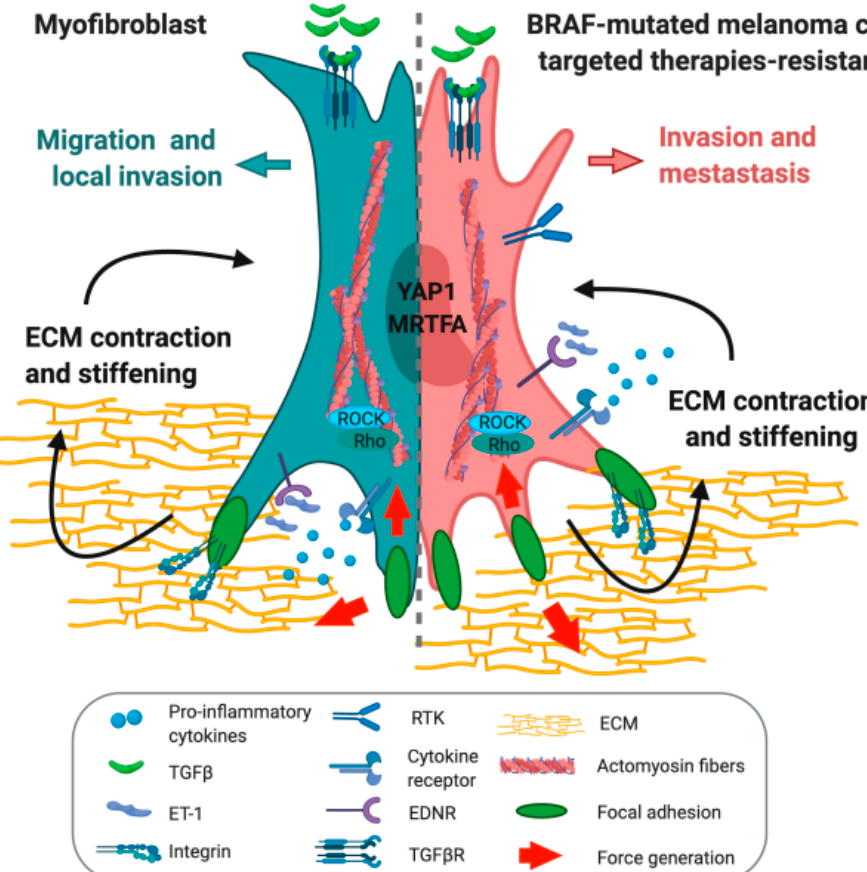
Figure 4. Comparison of the features of a myofibroblast and a targeted therapy-resistant melanoma cell. Schematic depiction of the reprogramming of melanoma cells toward a myofibroblast-like phenotype. TGF β : transforming growth factor beta; ET-1: endothelin 1; RTK: receptor tyrosine kinase; EDNR: endothelin receptor; TGF β R: transforming growth factor beta receptor; ECM: extracellular matrix; YAP1: Yes-associated protein 1; MRTFA: myocardin-related transcription factor A; ROCK: Rho-associated protein